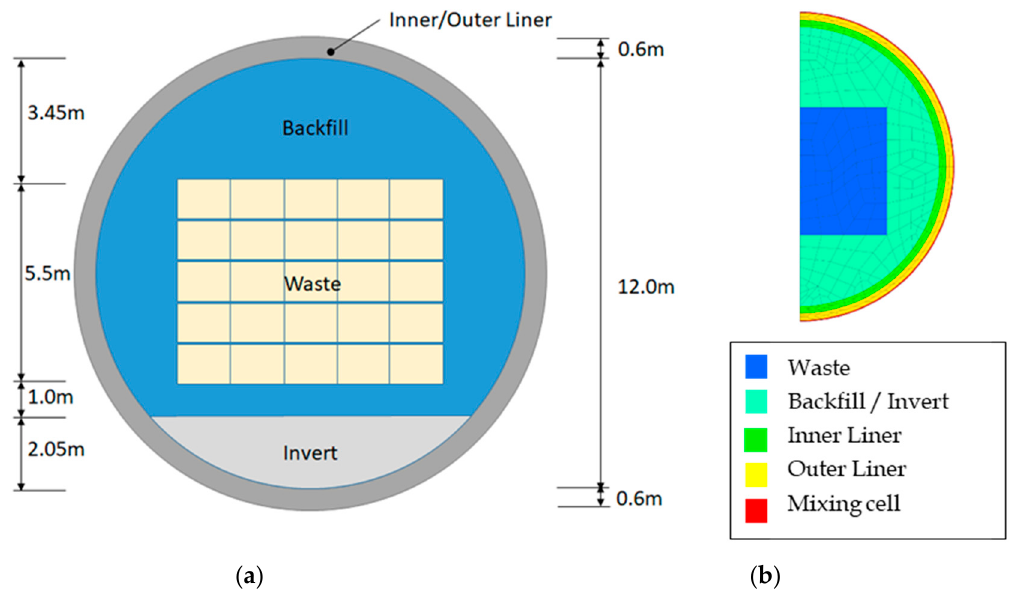
Figure 6. Cross-section of the TRU Gr 3/4 tunnel design ( a ) and half system that is modeled with GARFIELD-CHEM, showing the initially coarse grid at t = 0 years ( b ). The grid is constructed using quadrilateral elements and was computed using GMSH [30]. Table 1. Composition of cementitious features in the model. Minerals with zero initial concentration in the materials are treated as potential secondary minerals.